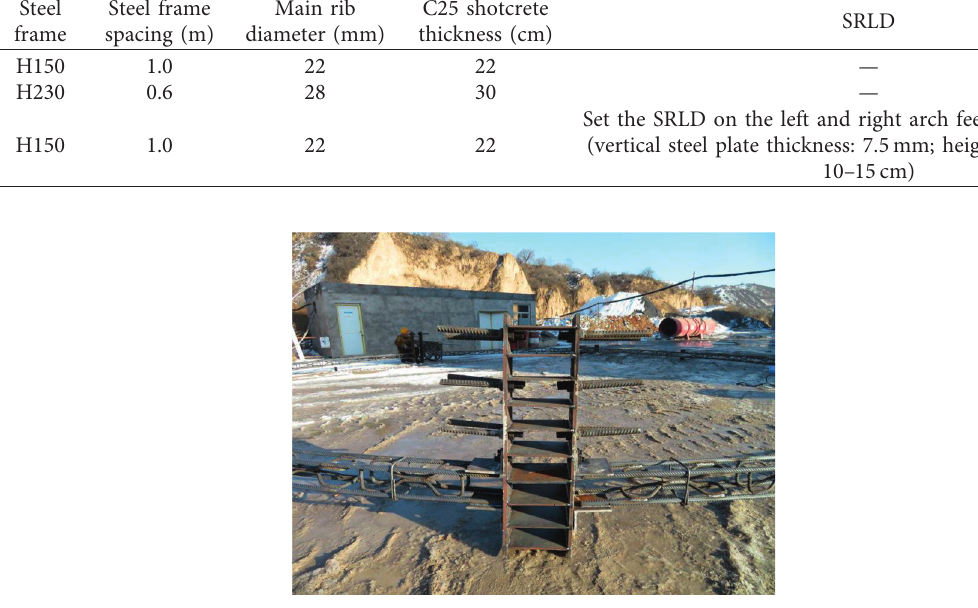
Figure 9: The assembled